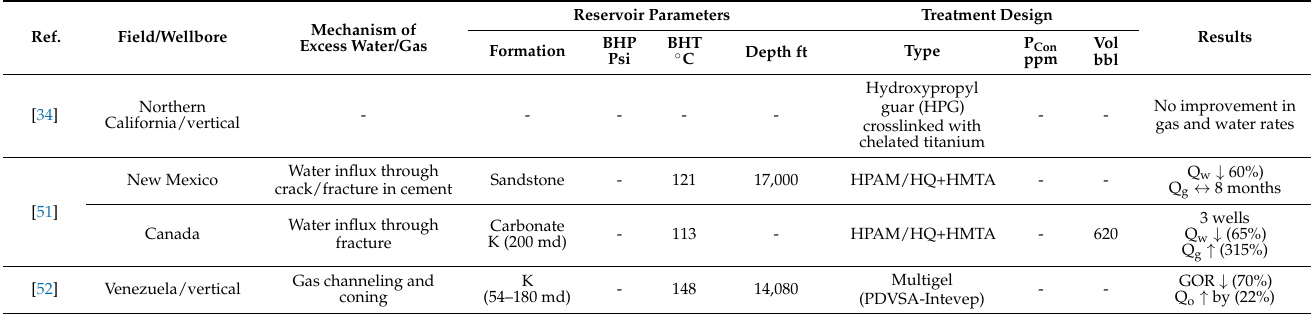
Table 7. Other organically crosslinked polymer gels.